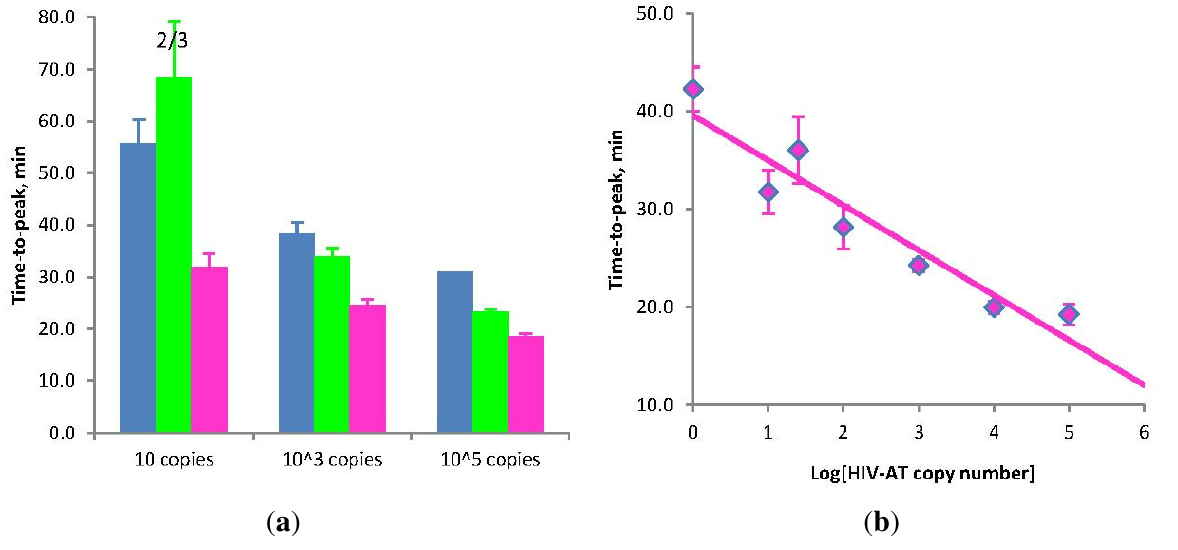
Figure 3. ( a ) Amplification times for LAMP without Loop primers (blue) and STEM-LAMP with Stem primers instead of Loop primers (pink) for 10, 1000 and 100,000 copies of the HIV-AT construct (restricted with Kpn1 and pre-denatured); STEM-LAMP without displacement primers for the same copy number is shown in green; ( b ) A six log dilution series of the HIV-AT construct using STEM-LAMP (all dilutions were measured and detected in triplicate unless indicated otherwise). Final primers concentrations were: sHIV-BIP, sHIV-FIP, HIV-StemB and HIV-StemF ― 1.6 µM each, HIV-DisplB and HIV-DisplF ― 0.4 µM each. Each set of data included three NTCs that remained clean throughout the duration of the assay and were not associated with any time-to-peak value (hence not shown graphically). Error bars represent standard deviations of triplicate